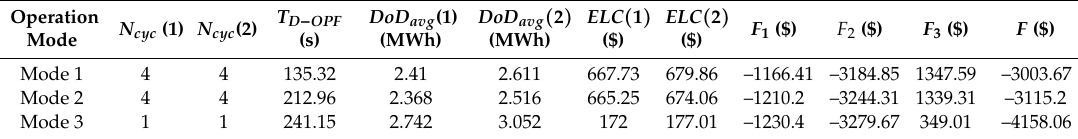
Figure 4. ( a ) Total active and reactive power demand; ( b ),( c ) Actual wind power of the first and second WF; ( d ),( e ) Curtailment factors of the first and second WF, respectively; ( f ) Capacitive reactive power dispatch of the first WF; ( g ) Capacitive reactive power dispatch of the second WF; ( h ) Slack bus voltage; ( i ) Active power at the slack bus; ( j ) Reactive power at the slack bus; ( k ) Total costs of active and reactive energy at the slack bus. Table 2. Comparison of the RT-DAR-OPF with the proposed flexible operation strategy to the results obtained by mode 1 and mode 2 for one